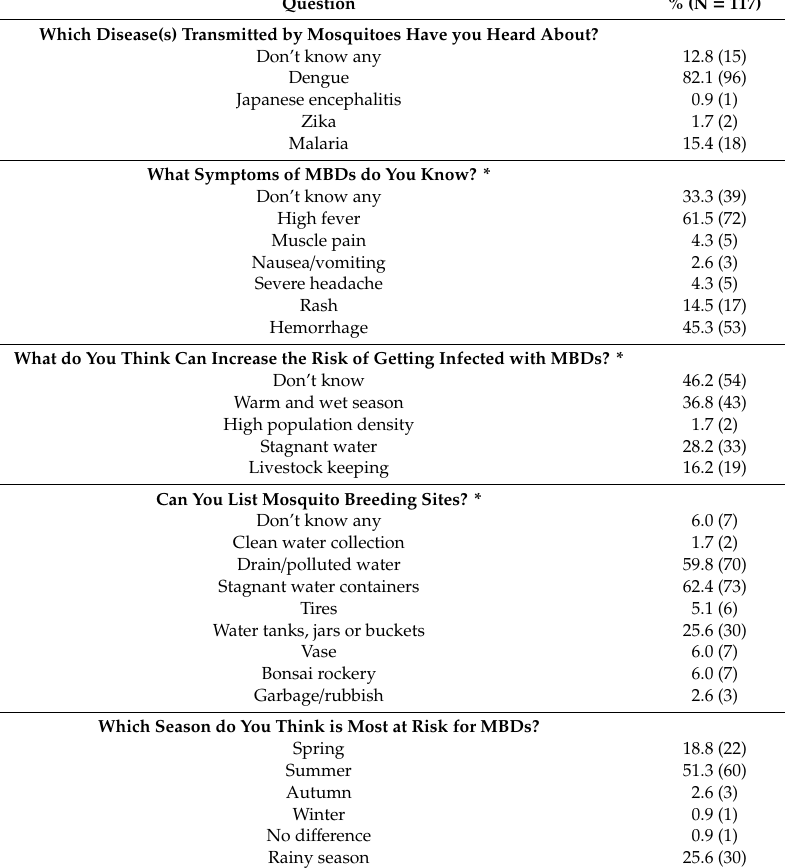
Table 2. Proportion of responses to various questions about